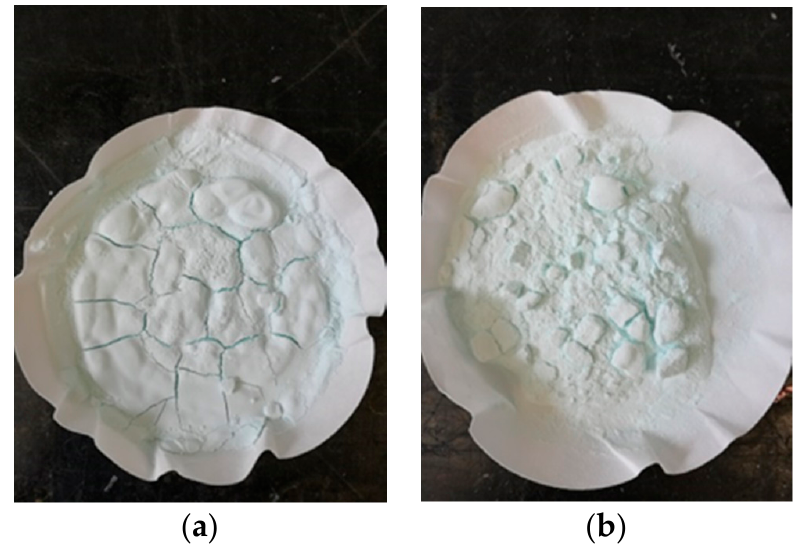
Figure 8. Microcapsules after a ( a ) 12 h and ( b ) 24 h drying period.